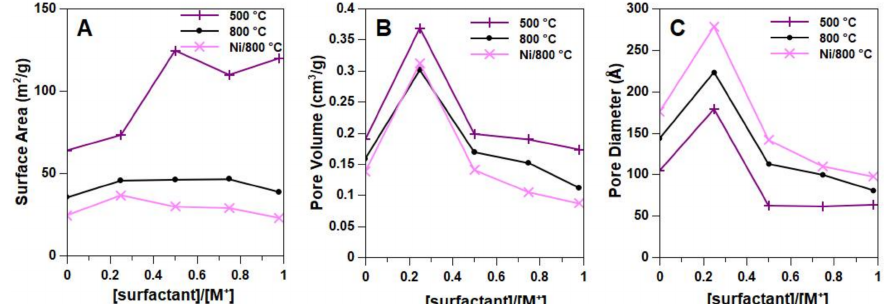
Figure 2. Effects of the amount of surfactant on the morphological properties of the ternary CeZrNd 0.07 composition in fresh state (calcined at 500 ◦ C), after calcination at 800 ◦ C, and loaded with Ni followed by calcination at 800 ◦ C: ( A ) Surface Area; ( B ) Pore Volume; ( C ) Pore Diameter.